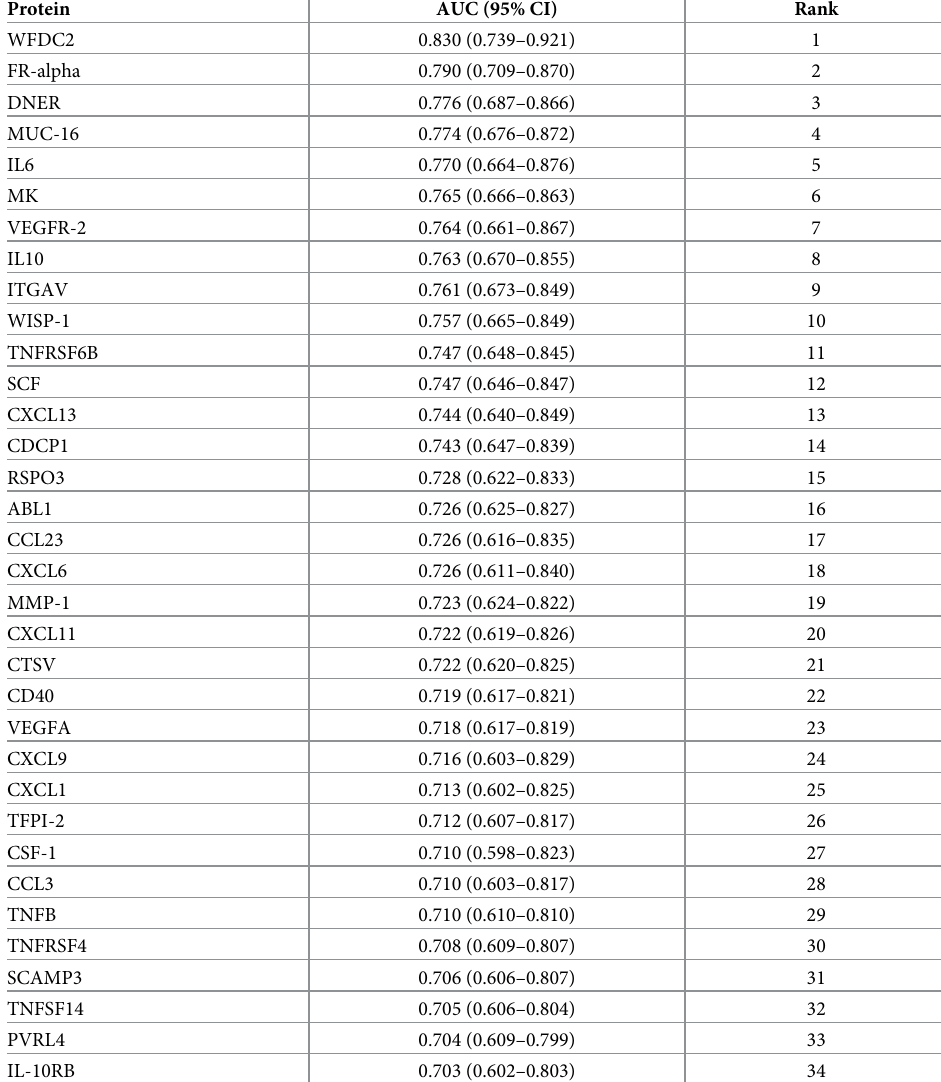
Table 3. AUC for individual biomarkers. Benign tumors vs. cancer, AUC > 0.7.